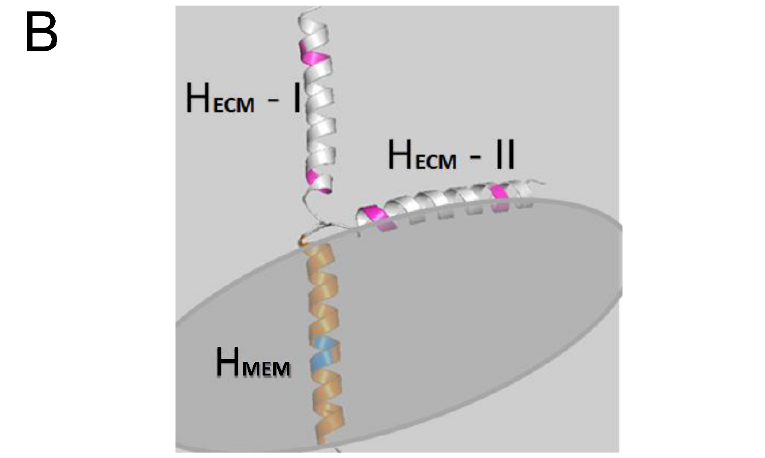
Figure 1. A β peptide sequences and membrane-associated structures. ( A ) Full-length APP protein is shown with locations of β - and γ -secretase cleavage sites as indicated. The wild type APP amino acid sequence is shown on the insert starting from β -secretase cleavage site (671) until the end of the transmembrane domain (723). Locations of γ -secretase cleavage sites resulting in generation of A β 40 and A β 42 peptides (711 and 713) are indicated by arrows. The bar diagram shows domain structure of A β peptide that consists of transmembrane (H MEM ) and extramembrane (H ECM ) α -helices. Locations and amino acid changes resulting from non-amyloidogenic APP-FAD mutations in H ECM region are indicated below wild type sequence that is shown in green. ( B ) Models of A β peptide association with membrane in two different conformations of H ECM α -helix. In model I H ECM is perpendicular to the membrane, in model II H ECM interacts with the membrane as a result of a 90 degree turn following H MEM . The positions of non-amyloidogenic APP-FAD mutations in H ECM domain are indicated in pink. The orange-color region of H MEM is a subject to the proteolysis by γ -secretase at positions indicated by blue for Aβ40 and Aβ42.